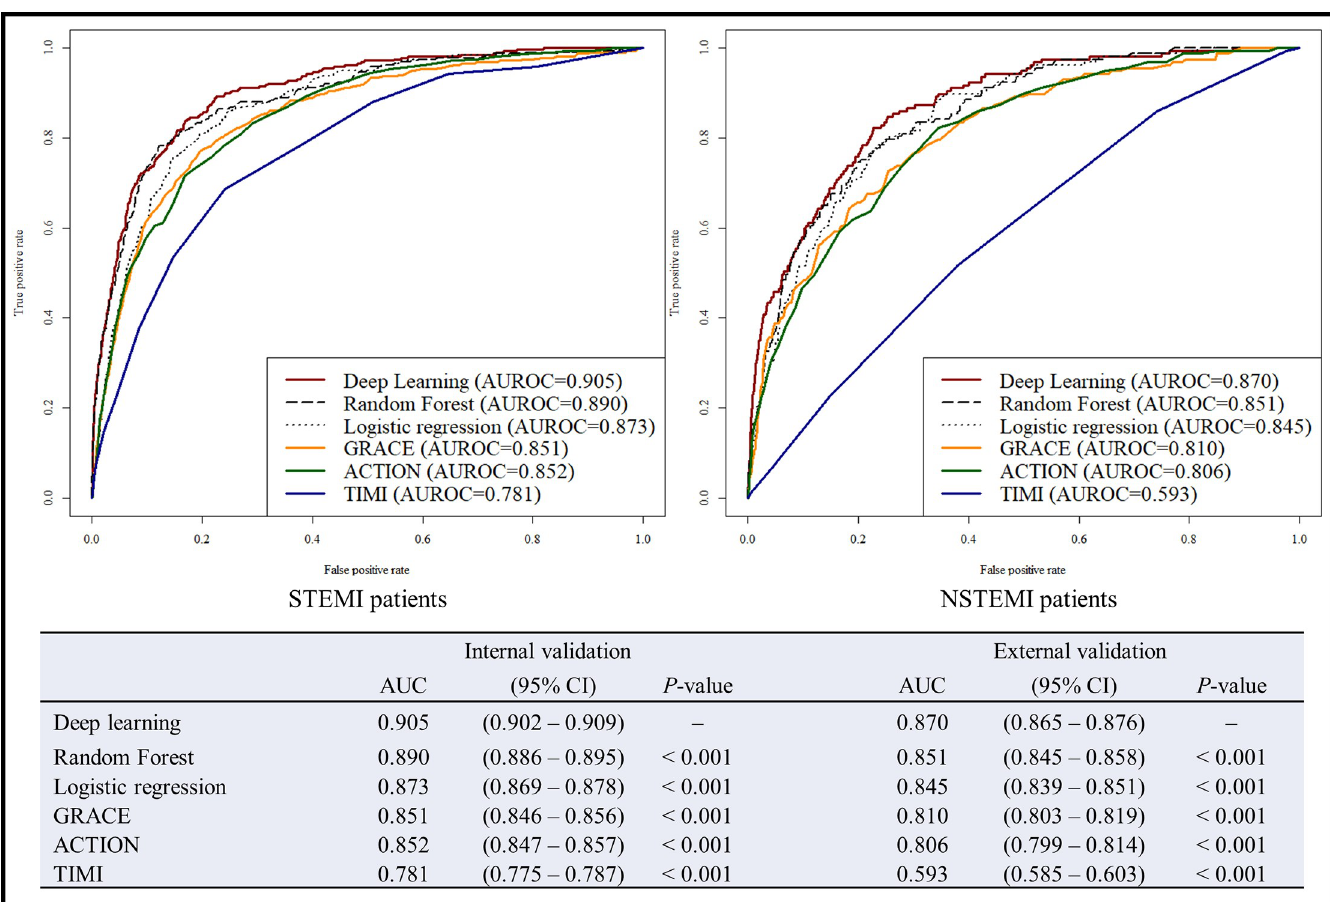
Fig 3. Receiver operating characteristic curve for predicting in-hospital mortality. AUC denotes area under the receiver operating characteristic curve, CI confidence interval, GRACE global registry of acute coronary event, TIMI thrombolysis in myocardial infarction.